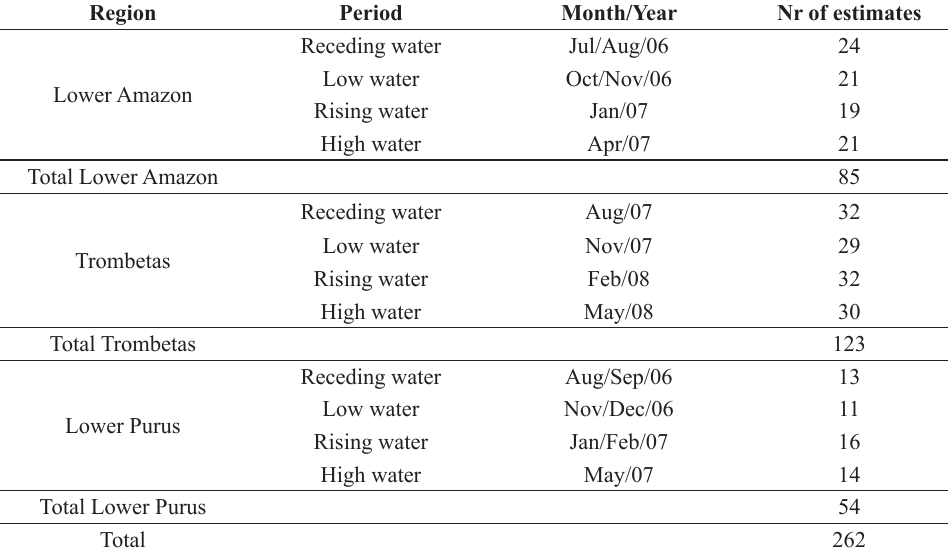
Sampling effort in the three study areas by seasonal